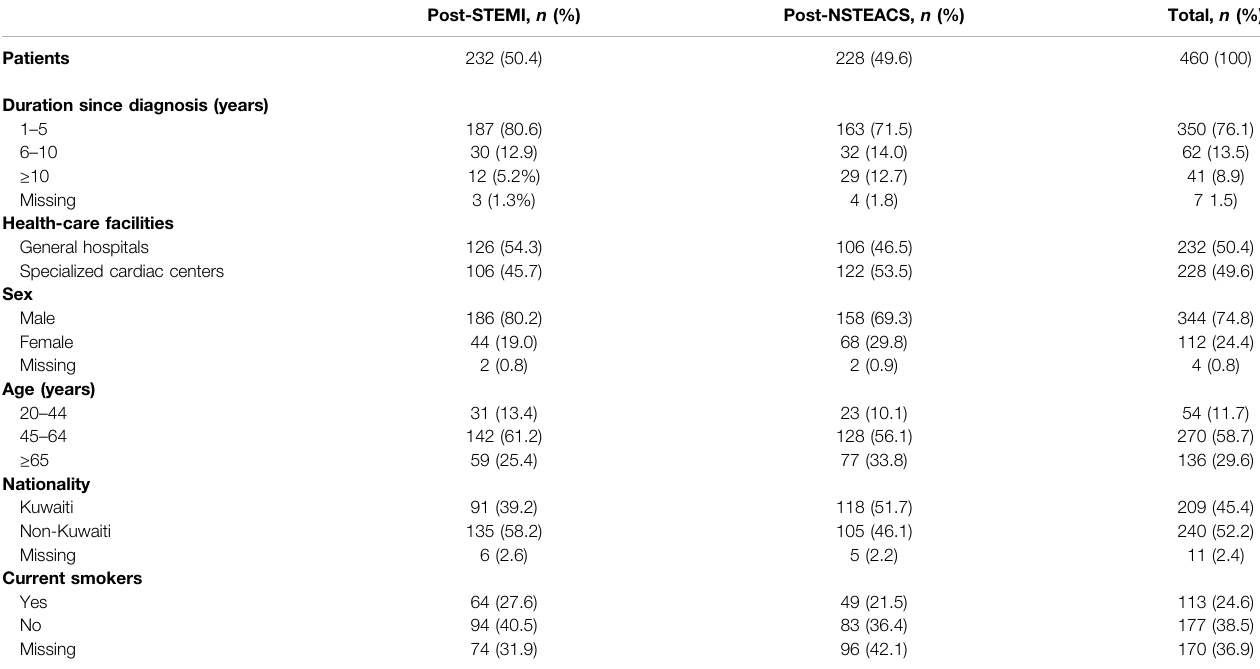
TABLE 3 | Demographic and other characteristics of patients ( n (cid:1)